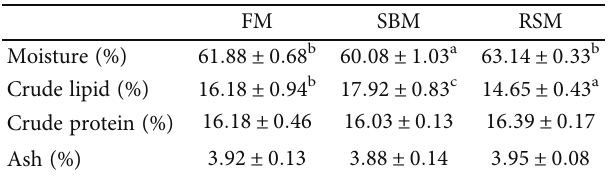
Table 6: E ff ects of di ff erent protein sources on body composition of female yellow cat fi sh